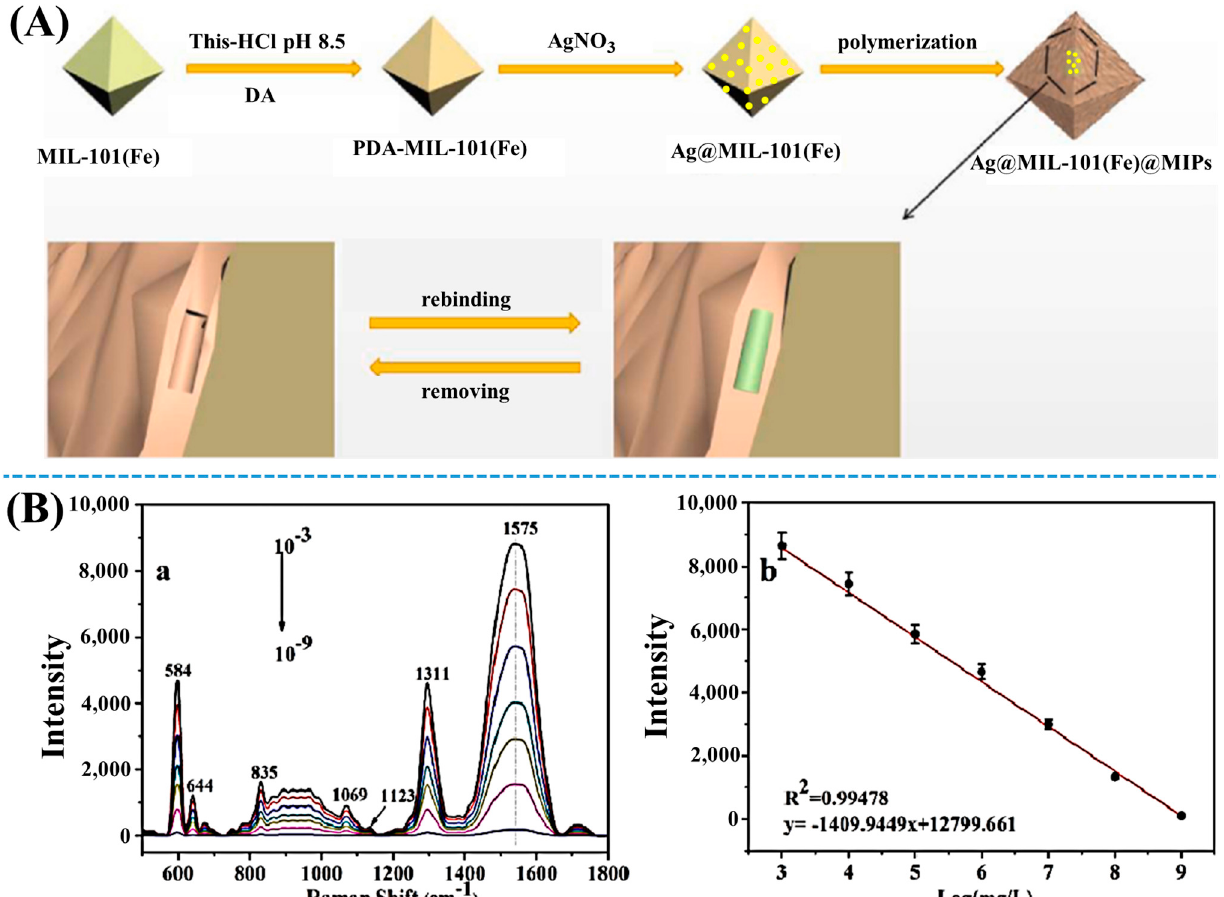
Figure 12. ( A ) Schematic diagram of the fabrication process of uniformed MOF structures of Ag@MIL-101 (Fe)@MIPs. ( B ) (a) MOF-based Raman spectra at different concentrations of 2,6-DCP. (b) A linear curve of logarithmic 2,6-DCP concentration-correlated Raman intensities at 1575 cm − 1 . Adapted from [42].